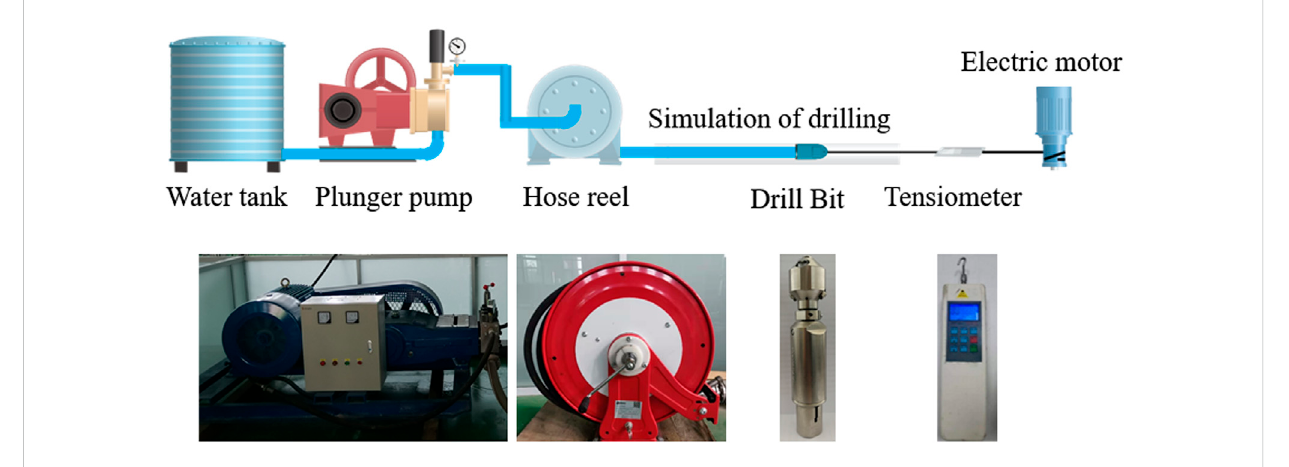
FIGURE 2 Schematic diagram of the experimental system.